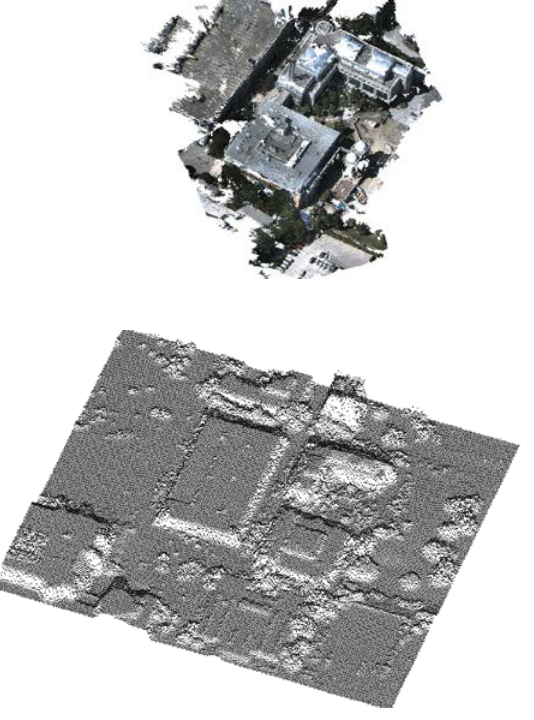
Figure 6. Illustration of the second dataset used for the co- registration experiment. Top: Photogrammetric point clouds generated by SfM from UAV. Bottom: Airborne laser scanning point